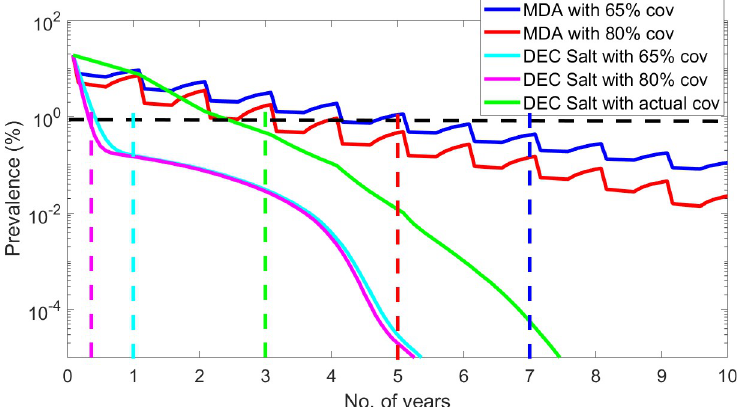
Fig 3. Timelines to reach the WHO recommended 1% mf threshold for MDA implanted at 65% and 80% coverage and DEC-medicated salt at 65%, 80%, and actual population coverages. The median model predicted trajectory is shown for each intervention strategy. The black dotted horizontal line indicates the WHO recommended 1% mf prevalence threshold. The blue, red, sky blue, purple and green dotted vertical lines indicate the time points to reach 1% mf threshold using either MDA at 65% and 80% coverages or DEC Salt at 65%, 80%, and actual coverage,